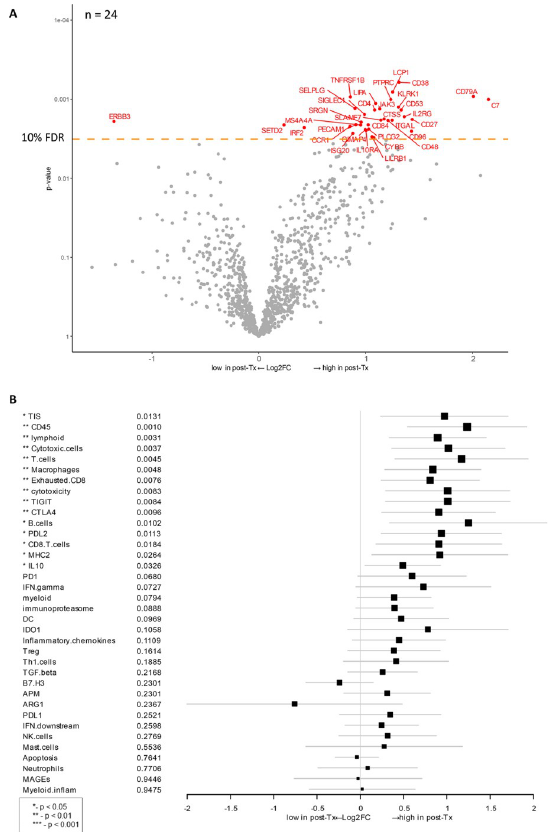
Fig 4. Therapy-induced changes after HDI and ipilimumab treatment vs. baseline. A ) Volcano plot of unadjusted p -value vs. log2-fold change of the differential expression after treatment. Dots corresponding to genes that are significant with an FDR (false discovery rate) less than 10%. This analysis includes data from 24 patients (n = 24) for whom both baseline and post-treatment samples were available. B ) Forest plot of difference of gene signature scores after treatment. The position of the squared dots denotes the difference of score, and the size denotes the statistical significance. The horizontal lines are the Wald-type confidence intervals. The � sign denotes the significance of p -value ( < 0.01 �� , < 0.05 � ).